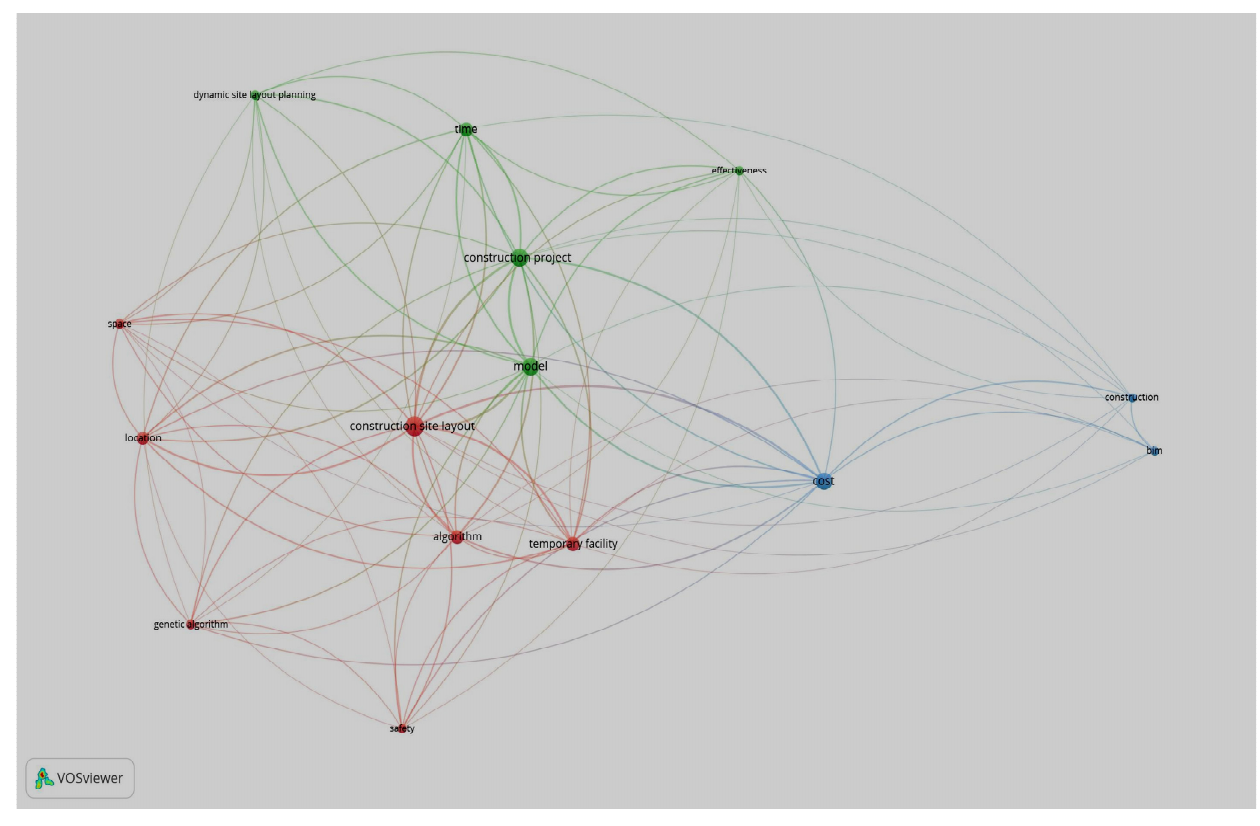
Figure 2. Visualized map of network.